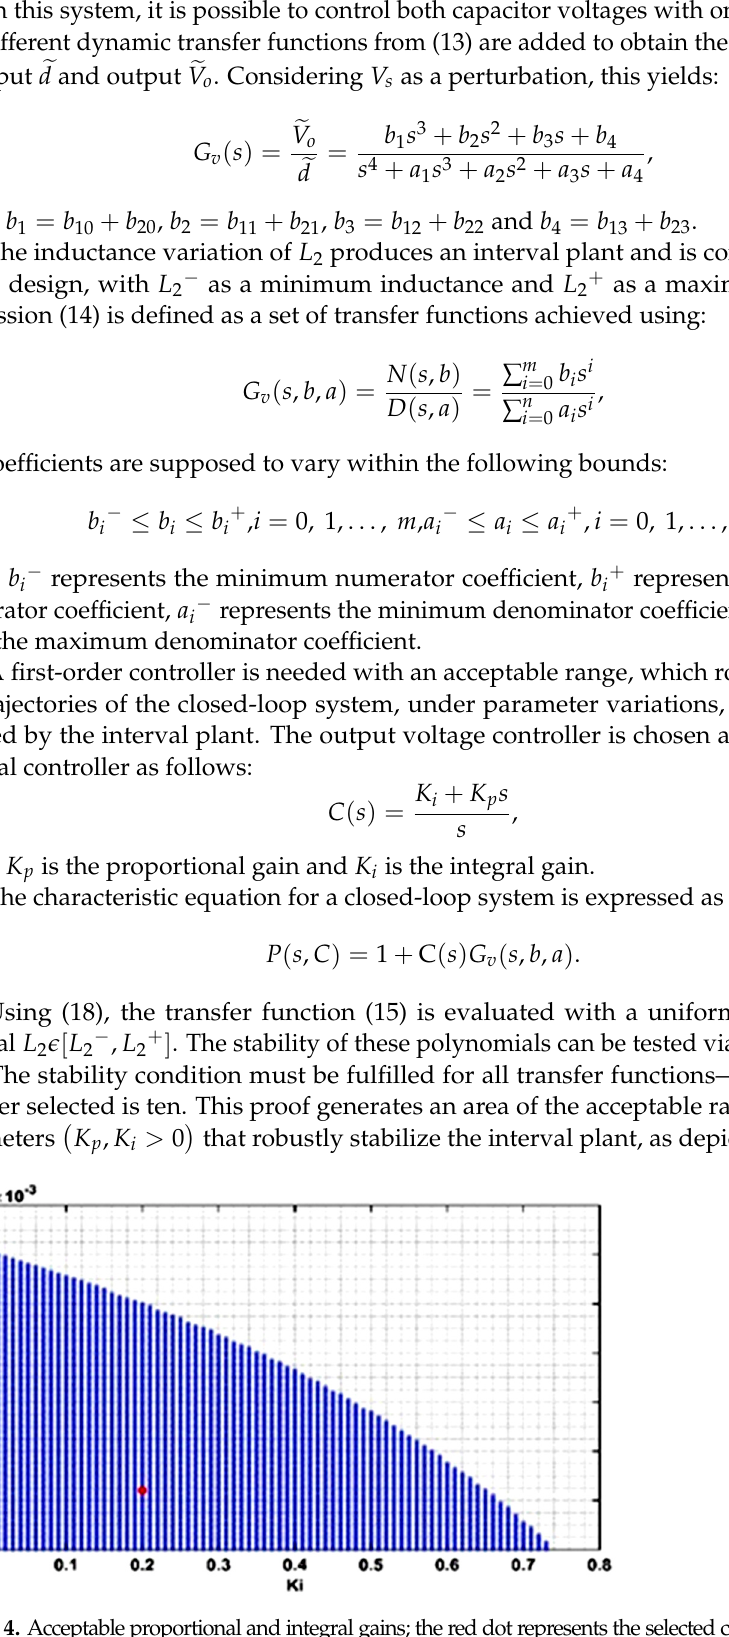
Figure 4. Acceptable proportional and integral gains; the red dot represents the selected controller parameters.